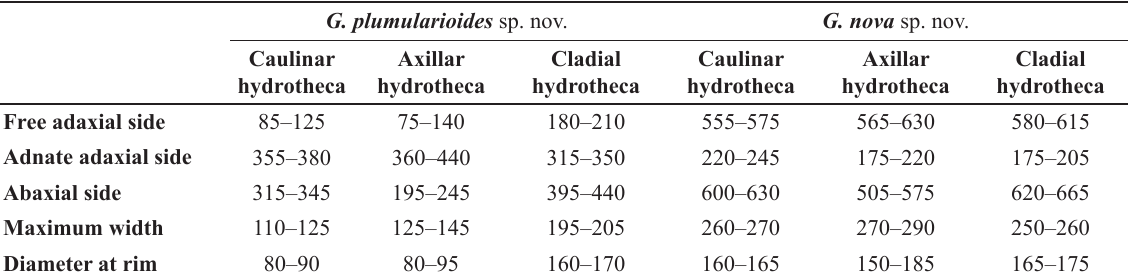
Table 2. Measurements (in µm) of hydrothecae of Gonaxia plumularioides sp. nov. and G. nova sp. nov. G. plumularioides sp.